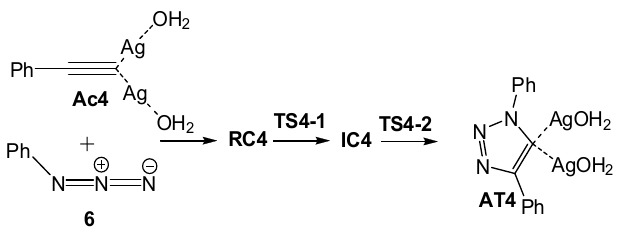
Figure 12. AgAAC reactions of the dinuclear Ac4 species with 6 .